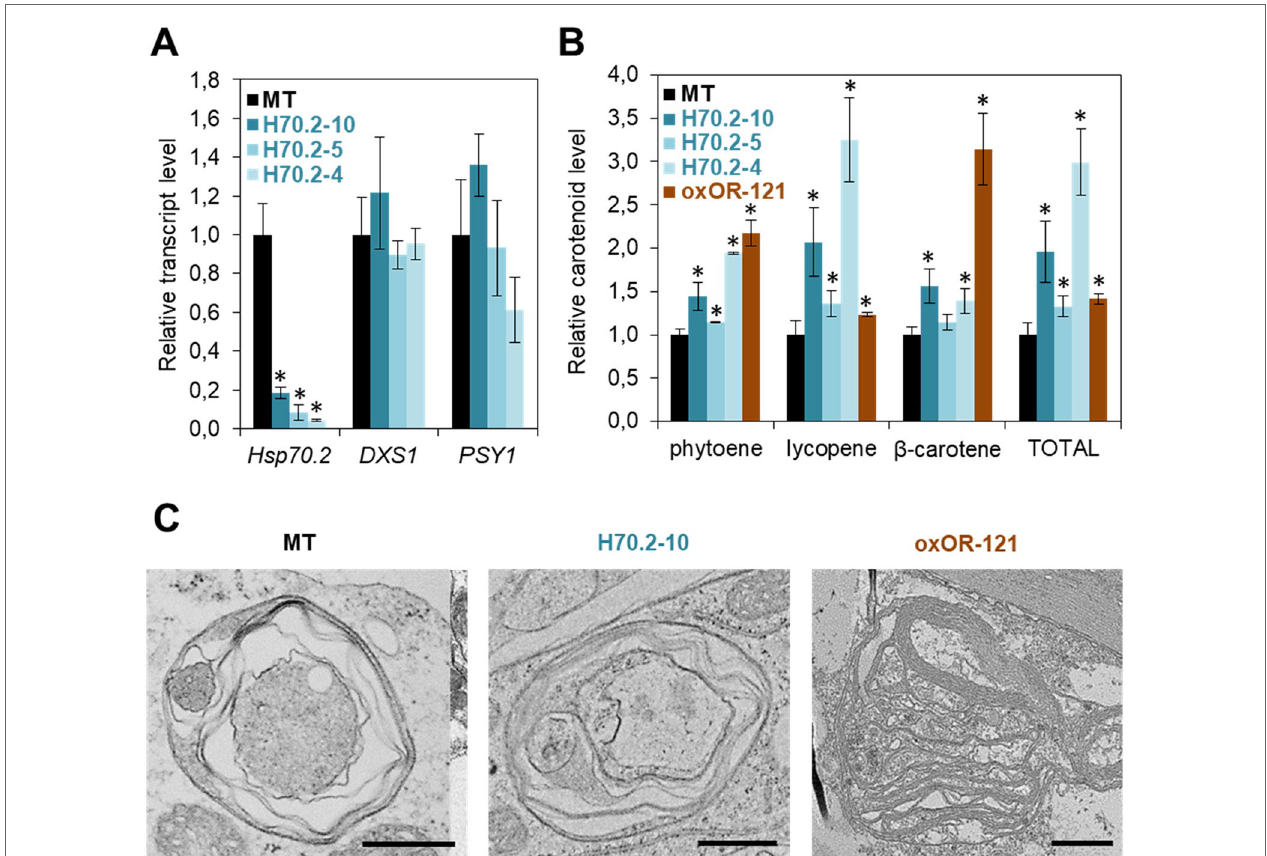
FIGURE 2 | Hsp70 and OR chaperones differentially control carotenoid biosynthesis in tomato. (A) Transcript levels of the indicated genes in the pericarp of red ripe fruits. Tomato MicroTom (MT) plants were transformed with an amiRNA construct to silence the Hsp70.2 gene during fruit ripening. Ripe fruits from greenhouse- grown untransformed and transgenic T1 plants were collected at 52 days post-anthesis (dpa) and used for real-time quantitative PCR (qPCR) analysis of Hsp70.2 , DXS1 (Solyc01g067890) and PSY1 (Solyc03g031860) expression using the ACT gene (Solyc04g011500) as normalizer. Mean and SD values (n ≥ 2) are shown relative to those in untransformed MT fruit. Asterisks mark statistically significant differences relative to MT samples (T-test, P < 0.05). (B) Levels of carotenoids in the pericarp of red ripe fruits from the indicated lines. MT plants were transformed with a construct previously used to constitutively overexpress Arabidopsis OR-His under the control of the 35S promoter in tomato plants of the M82 cultivar (Yazdani et al., 2019). A representative T1 line was selected based on the distinctive orange color of their fruit. T2 plants of this line (oxOR-121) were grown in the greenhouse together with untransformed controls and T2 plants of Hsp70.2 -silenced lines analyzed in (A) , and ripe fruits were collected at 52 dpa for pericarp carotenoid extraction and analysis by HPLC. Mean and SD values (n ≥ 2) of individual and total carotenoid levels are shown relative to those in MT fruit. Asterisks mark statistically significant differences relative to MT samples (T-test, P < 0.05). (C) Representative images of chromoplasts. Fruits were collected from the indicated lines at 52 dpa and used for TEM analysis of chromoplast ultrastructure. Bar, 1 µm. Previously described methods (D’Andrea et al., 2018) were used for amiRNA synthesis, plant transformation, RNA and carotenoid extraction, qPCR, HPLC, TEM, and statistical